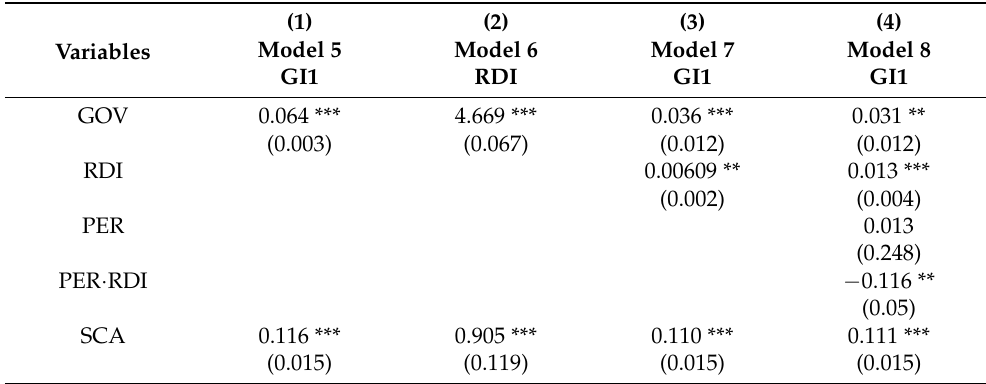
Table 4. Robustness test regression